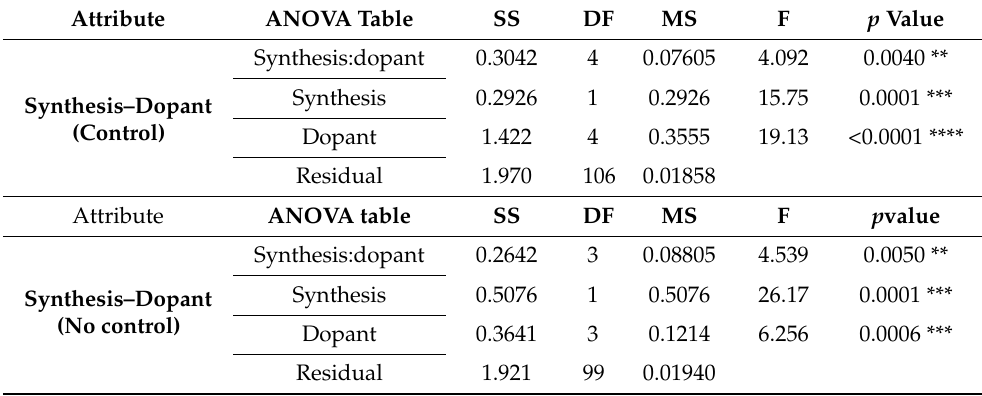
Table 8. Two-way ANOVA test for the inhibition % of DPPH in leaves.